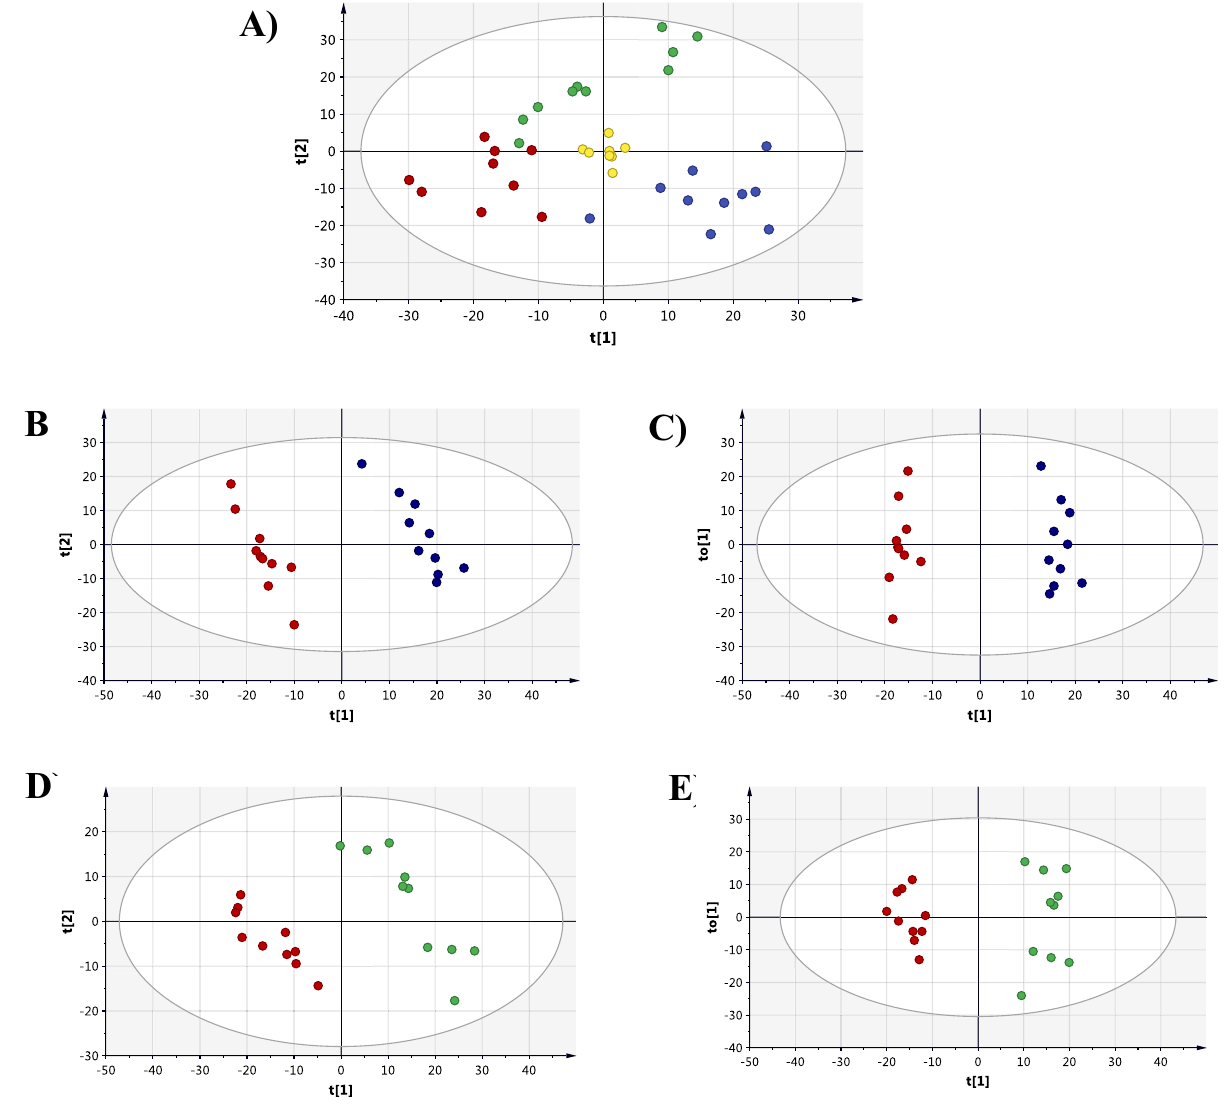
Figure 6. Scores plots of the extracellular metabolic profile of DU145 samples treated with sub-cytotoxic concentrations of C5 (Blue) and C6 (Green). Untreated control samples are in (Red) and QC samples are in (Yellow). ( A ) PCA (R 2 X = 0.637, Q 2 = 0.28), ( B ) PLS-DA (R2X = 0.36, R2Y = 0.99, Q2 = 0.89) and ( C ) OPLS-DA (R2X = 0.29, R2Y = 0.98, Q2 = 0.86) for C5-treated DU145 cells. ( D ) PLS-DA (R2X = 0.36, R2Y = 0.99, Q2 = 0.82) and ( E ) OPLS-DA (R2X = 0.39, R2Y = 0.95, Q2 = 0.82) for C6-treated DU145